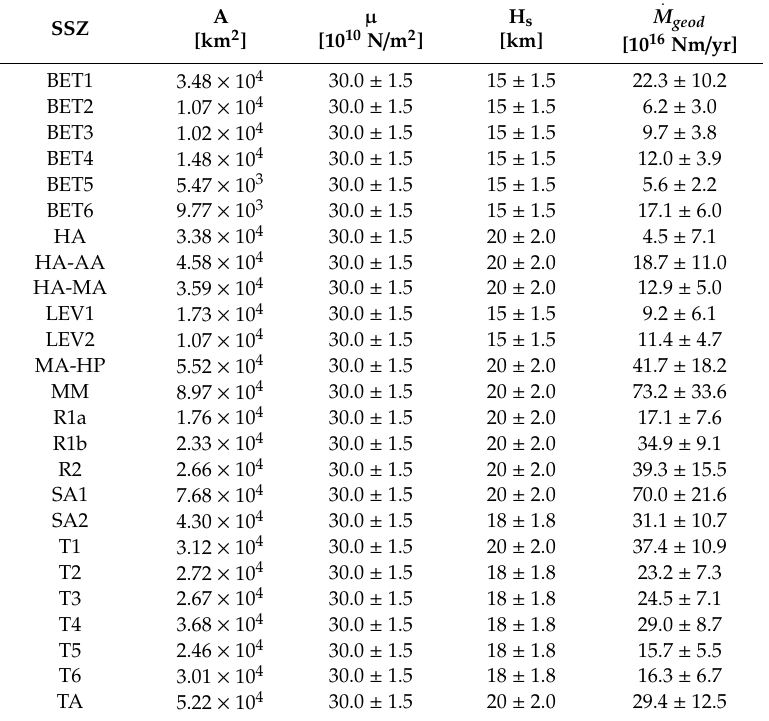
. M geod ) with associated error and adopted parameter values for each Table 2. Geodetic moment-rate ( seismic source zone (SSZ). A , area of the SSZ; µ , shear modulus for crustal rocks; H s , seismogenic thickness with a 10% variation for the lower and upper ranges (see Appendix B for additional details). Regarding the shear modulus µ , a value of 30 × 10 10 N / m 2 has been used, typical of average crustal rocks [77], and allowed for a 5% variation for the lower and upper